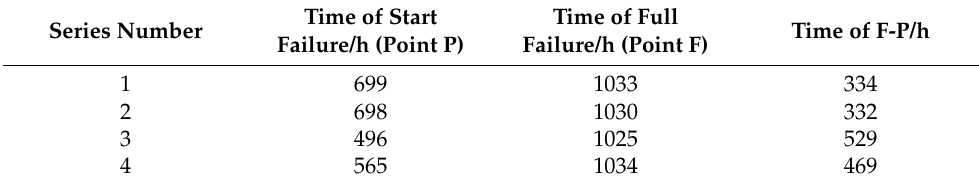
Table 4. Start and full failure times of each gear